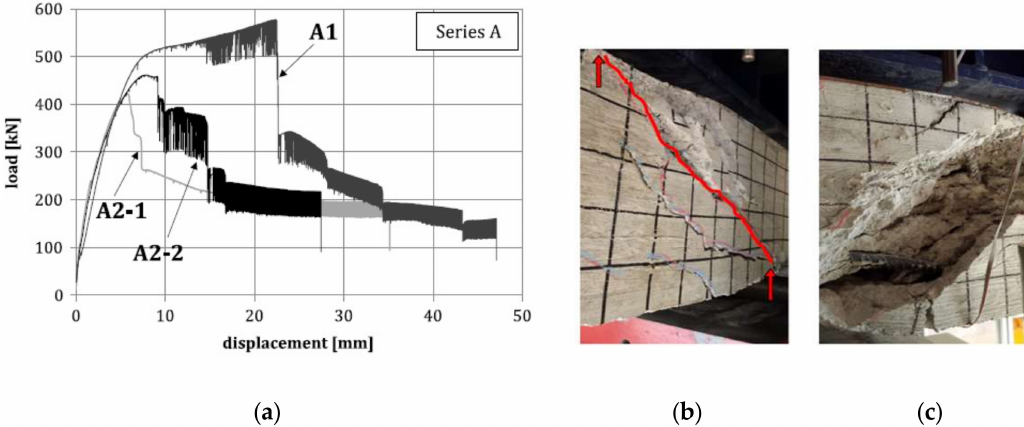
Figure 19. Series A: ( a ) load-deflection curves; ( b ) main diagonal shear crack (spec. A2-1); ( c ) “upper” chord (specimen placed upside-down) and tensile web bar of the truss across the diagonal crack (spec. A2-1).